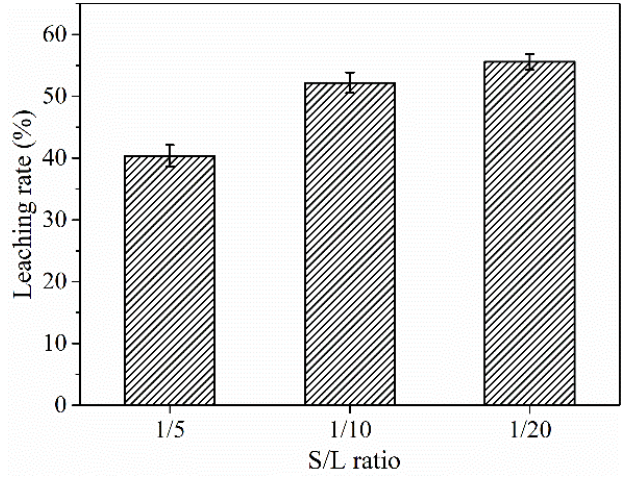
Figure 8. The effect of S/L ratio on REE leaching rate at 30 °C and 1.65 mol/L HCl for leaching 2 h.